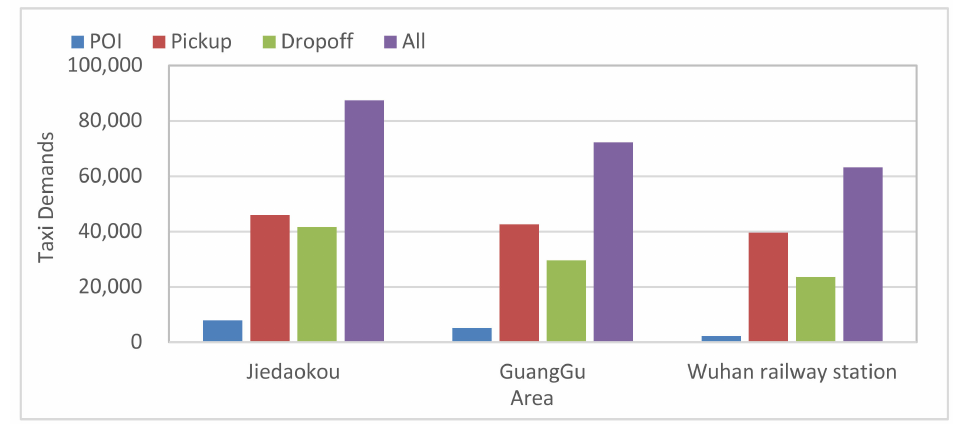
Figure 9. Distribution of POIs and taxi demands in different